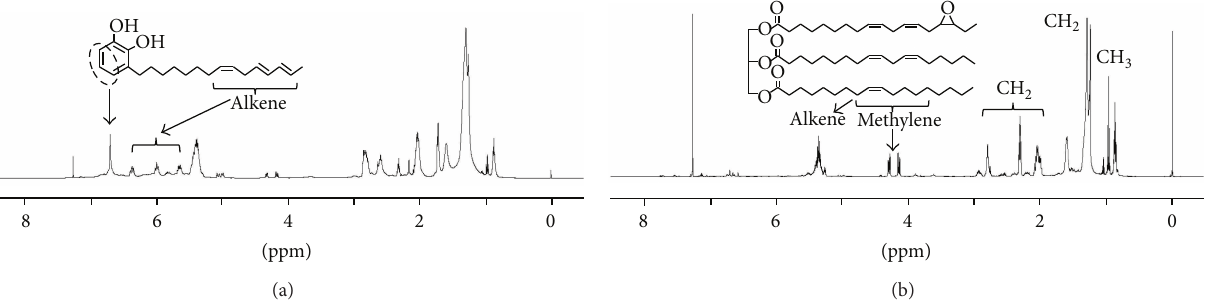
Figure 3: 500 MHz 1 H NMR spectra of acetone extracts from polymerization films after (a) 2 h and (b) 24 h polymerization, respectively. The polymerization of the KL paint was carried out with ELO-6 in the weight proportion of 10:1. The spectra were obtained in CDCl 3 as solvent at 30 ∘